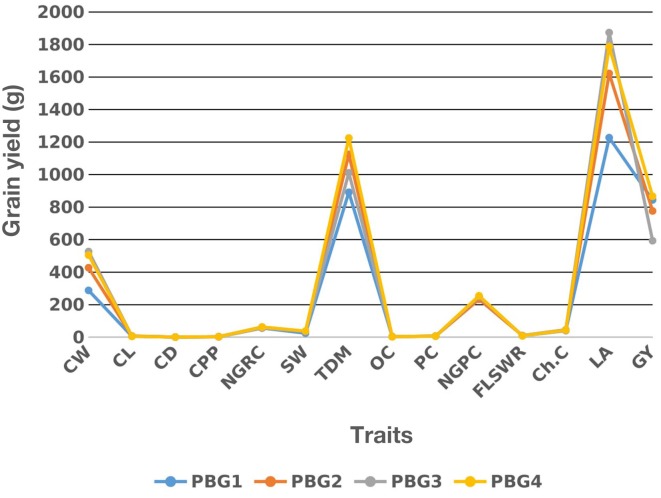
Mean performance of two drought sensitive (PBG1 and PBG2) and two drought tolerant (PBG3 and PBG4) maize inbred lines for grain yield and its attributing traits, see Section Materials and Methods for traits description.